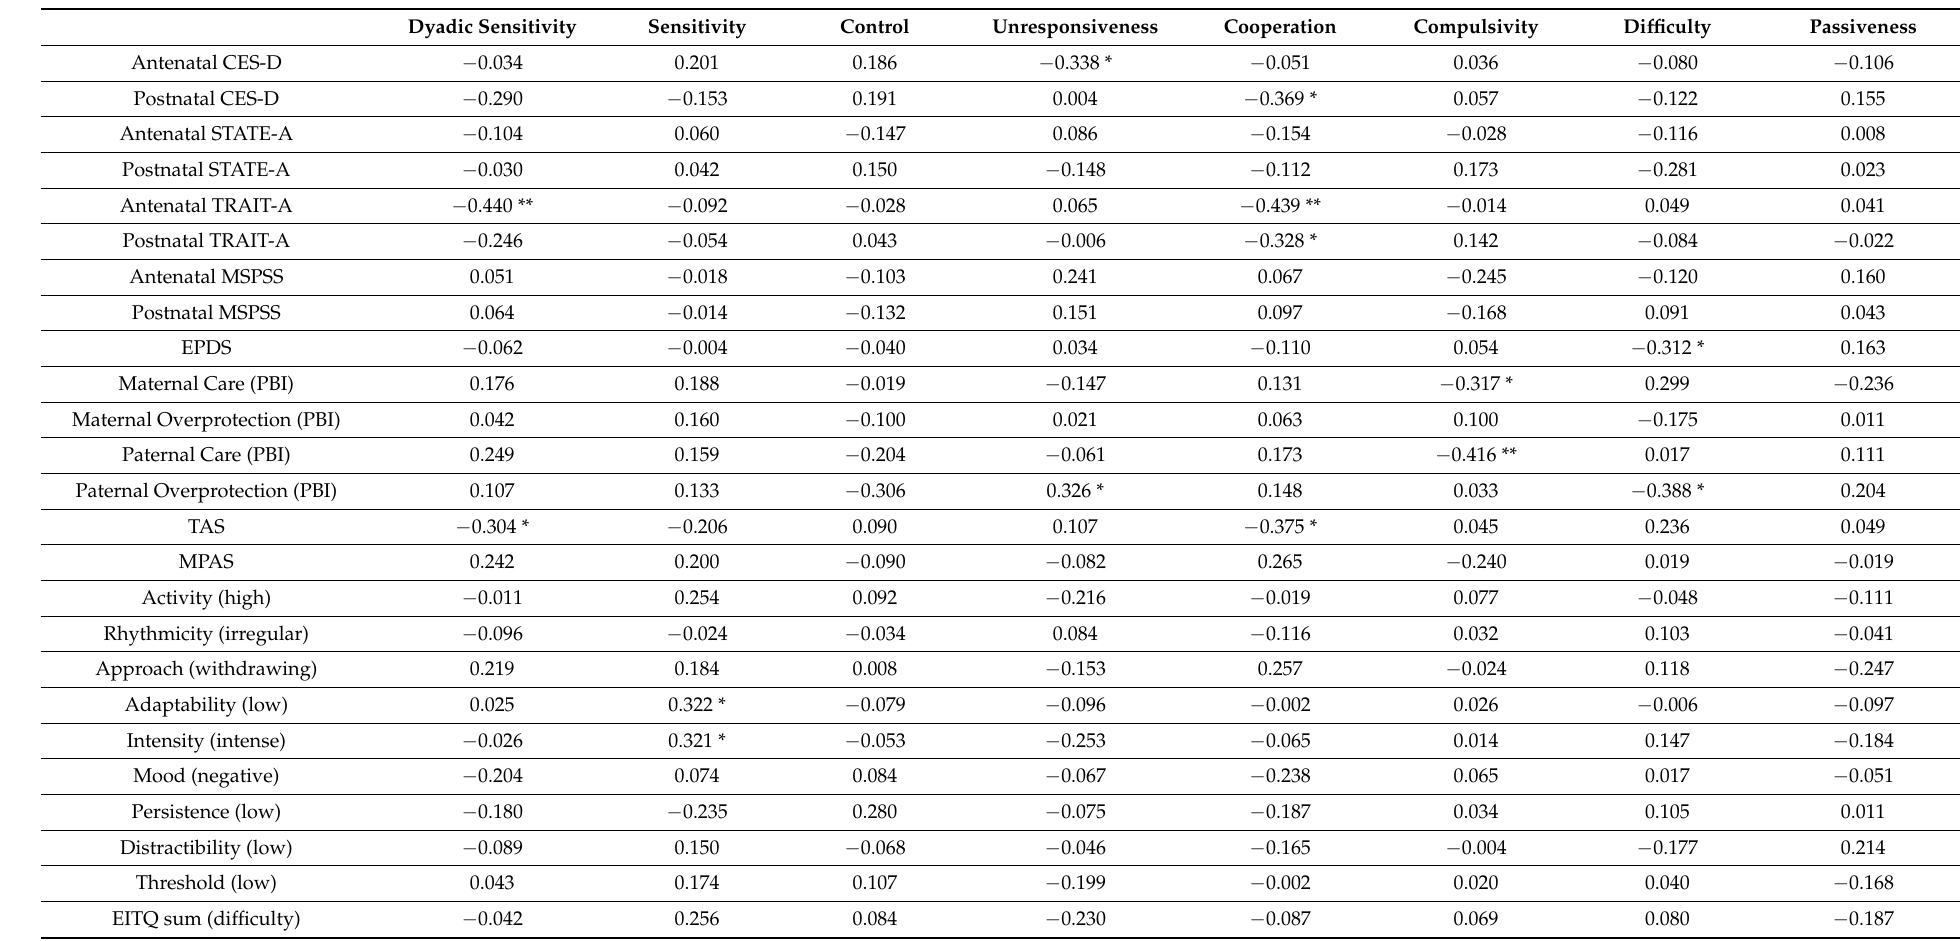
Table 7. Spearman’s correlations between CARE-Index scales, maternal well-being scales, and temperament scales. Dyadic